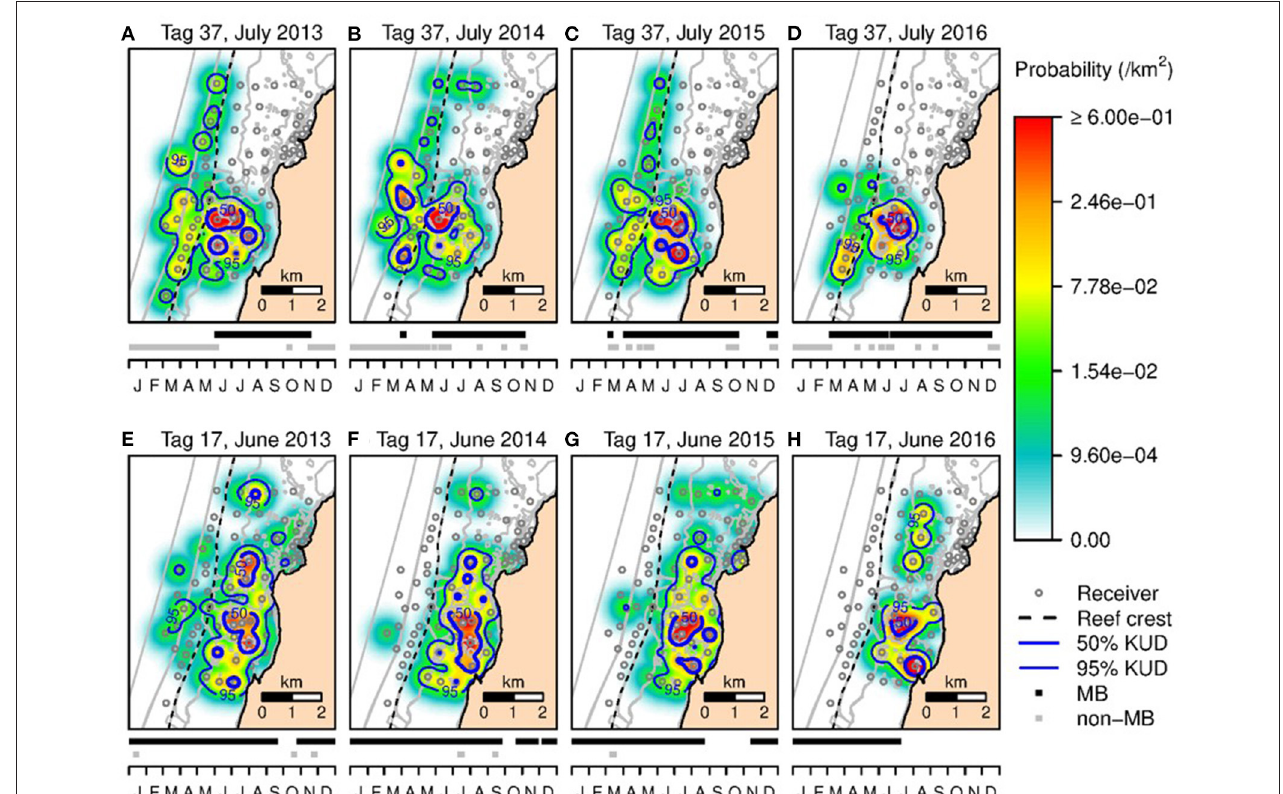
FIGURE 5 | The 50 and 95% KUD contours for an adult female N. acutidens (shark ID = 37) in July 2013 (A) , 2014 (B) , 2015 (C) , and 2016 (D) . (E,F) The 50 and 95% KUD contours for an adult male N. acutidens (shark ID = 17) in June 2013 (E) , 2014 (F) , 2015 (G) , and 2016 (H) . Shading reflects the conditional probability (per km 2 ) of a tagged shark occupying space within the array when it was within the array boundaries. Dashed line shows seaward edge of reef crest. The graph below each map shows the detection history in that year (with detections within the Mangrove Bay array and